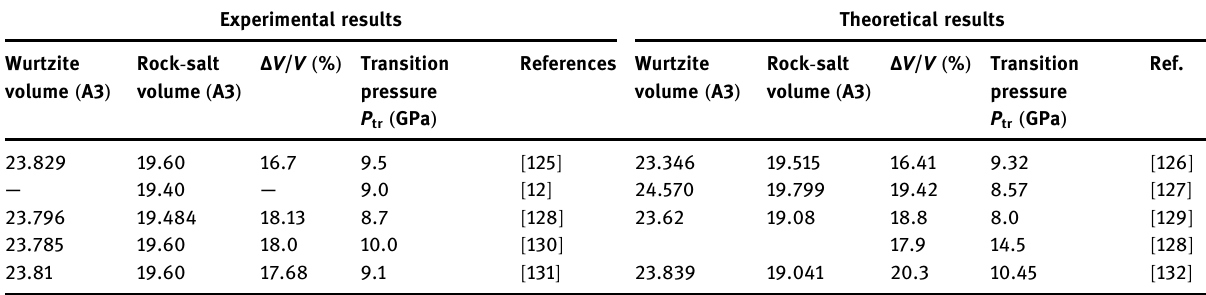
Table 2: Experimental and theoretical pressure parameters of